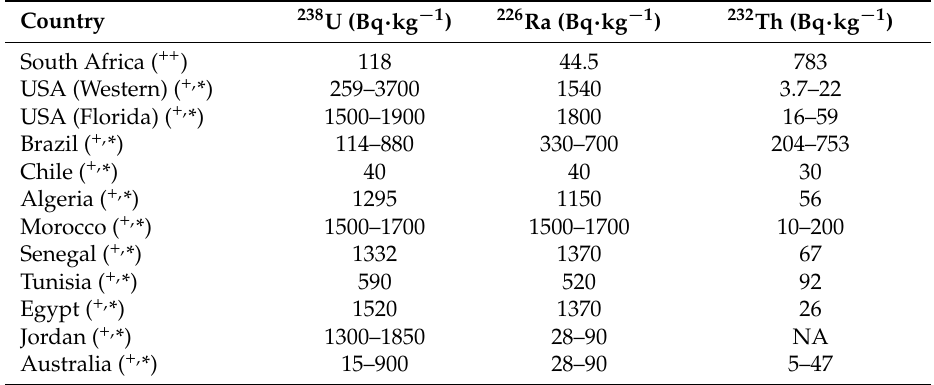
Table 4. Comparison of activity concentrations of 238 U, 232 Th and 226 Ra in rock phosphate from these study with other countries.